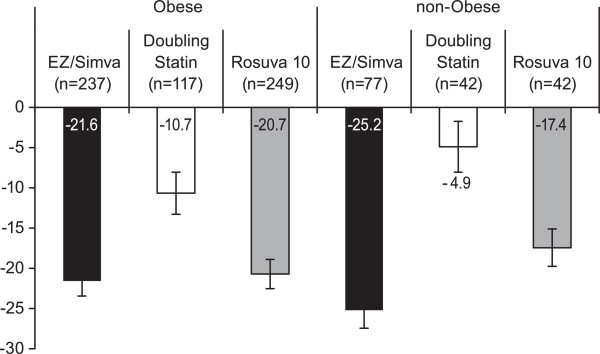
Least squares mean percent change from baseline in LDL-C in obese and non-obese subjects after 6 weeks of treatment. Bars represent standard error. (FAS population).